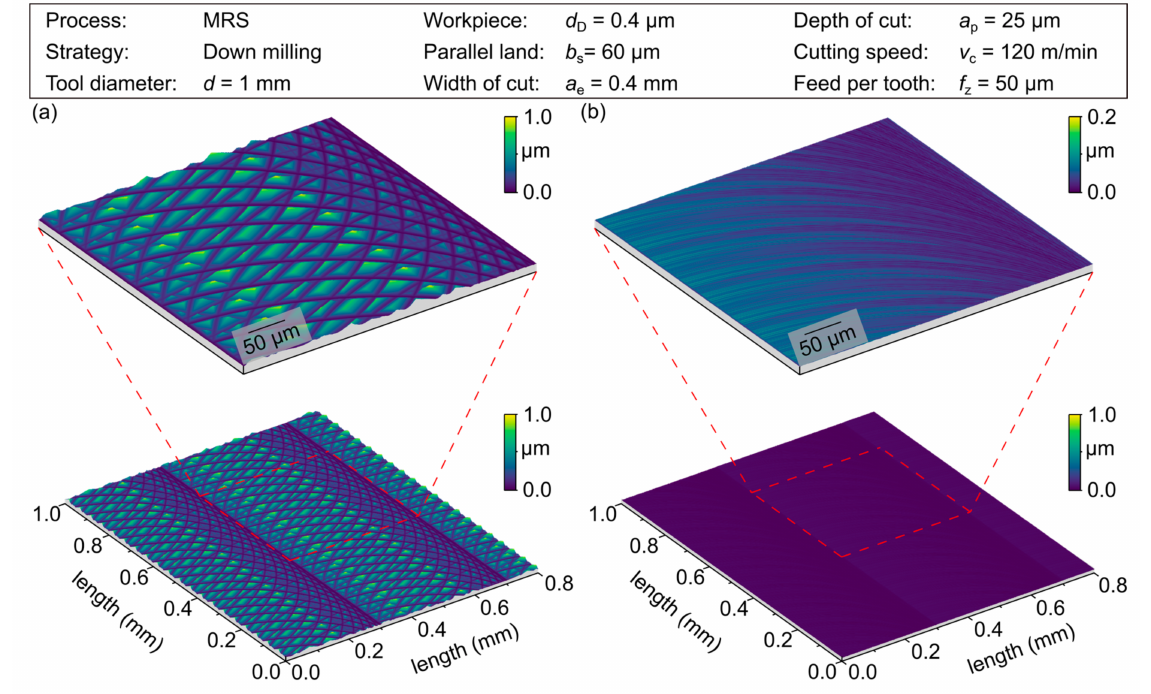
Figure 7. Surface topography simulated by material removal simulation (MRS) with ( a ) reference tool and ( b ) wiper tool with b s = 0.06 mm for f z = 0.05